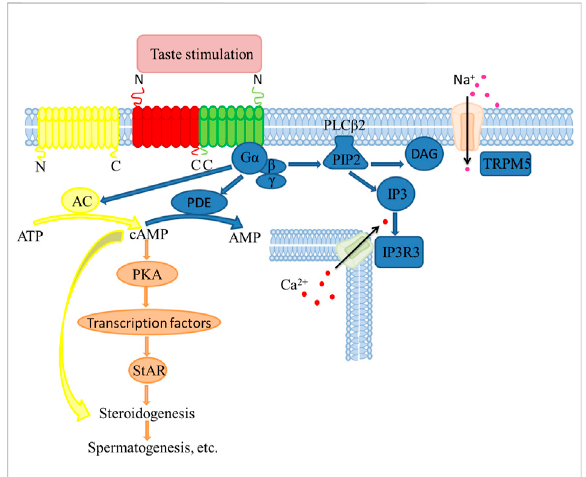
FIGURE 1 Molecular mechanismsinsteroidsynthesis regulated bytaste receptors in testicular Leydig